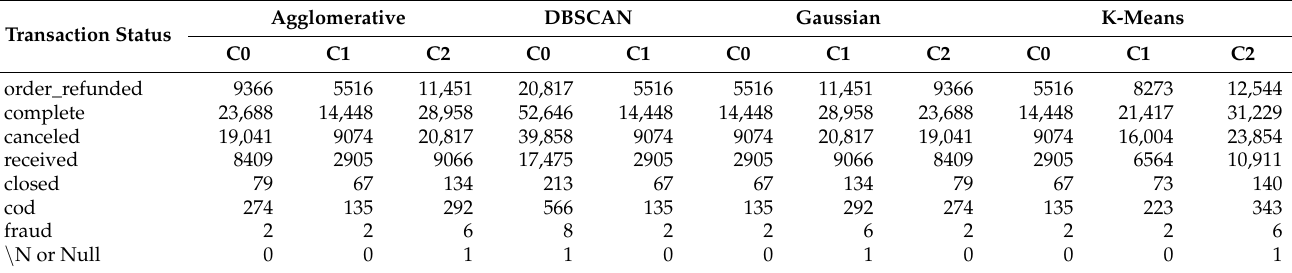
Table 8. Transaction status analysis value for different algorithm’s clusters.